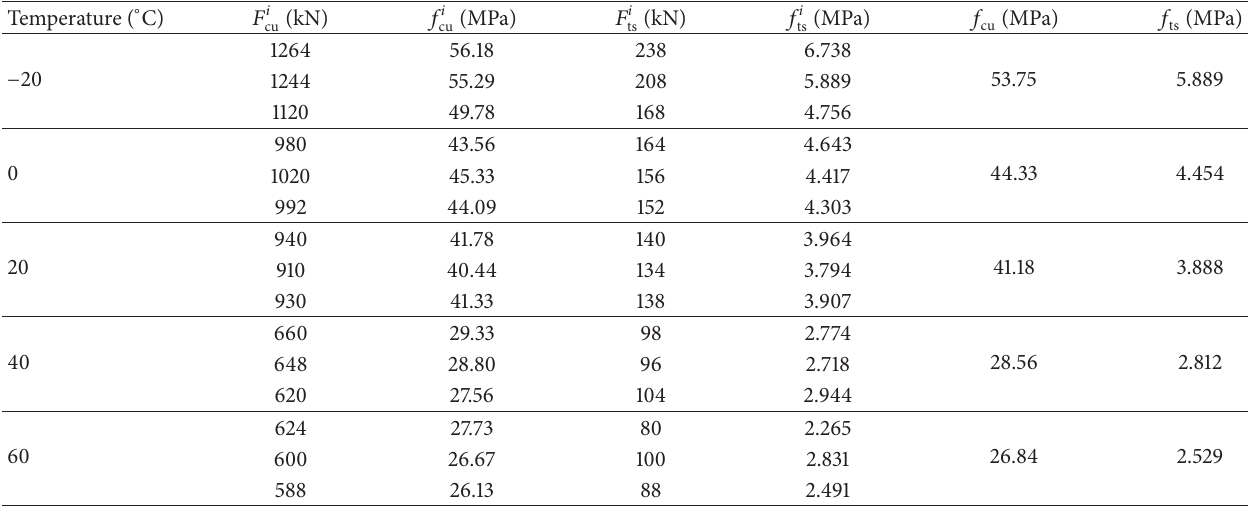
Table 2: Results of cube compressive strength and splitting tensile strength for concrete under different temperatures.